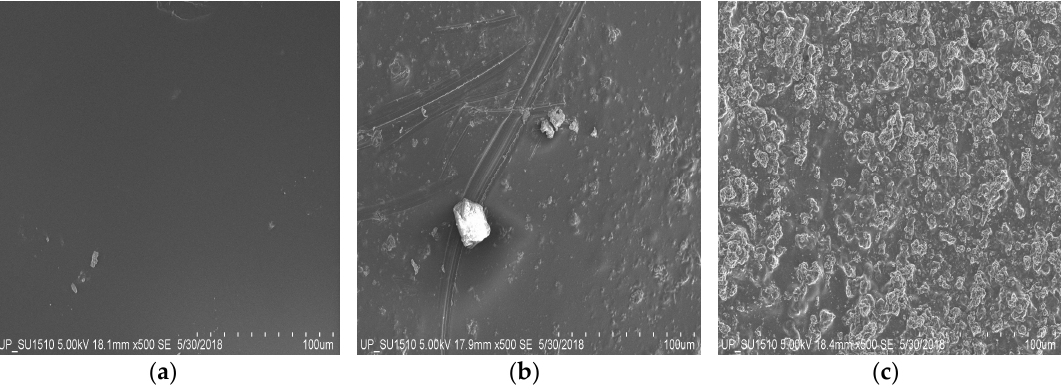
Figure 2. Scanning electron microscopy (SEM) images of polyaniline–chitosan (PAni–Cs) composite films observed at a magnification of 500×, accelerating voltage of 5 kV, and working distance of 18.1 mm. ( a ) Pure chitosan (Cs), ( b ) 1:10 PAni–Cs, and ( c ) 1:1 PAni–Cs.